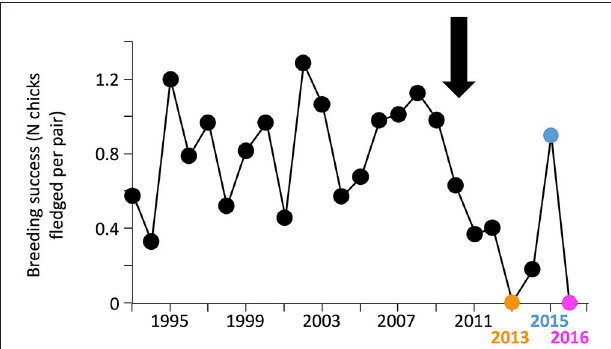
FIGURE 1 | Reproductive success of Adélie penguins between 1994–95 and 2016–17 at Ile des Petrels, Terre Adélie. The 2 years when no (or virtually no) chicks survived are indicated by orange (2013–14) and magenta dots (2016–17). The year 2015–16 where breeding success was relatively high is indicated by a blue dot. This color code is used in the rest of the article when zero success years are compared with the high success year. The arrow indicates the collapse of the Mertz glacier (see